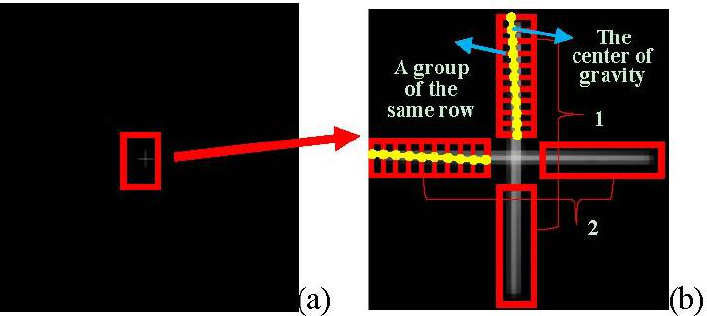
Figure 14. Image of the emergent crossline of the theodolite. ( a ) is original image; ( b ) is partially enlarged view.